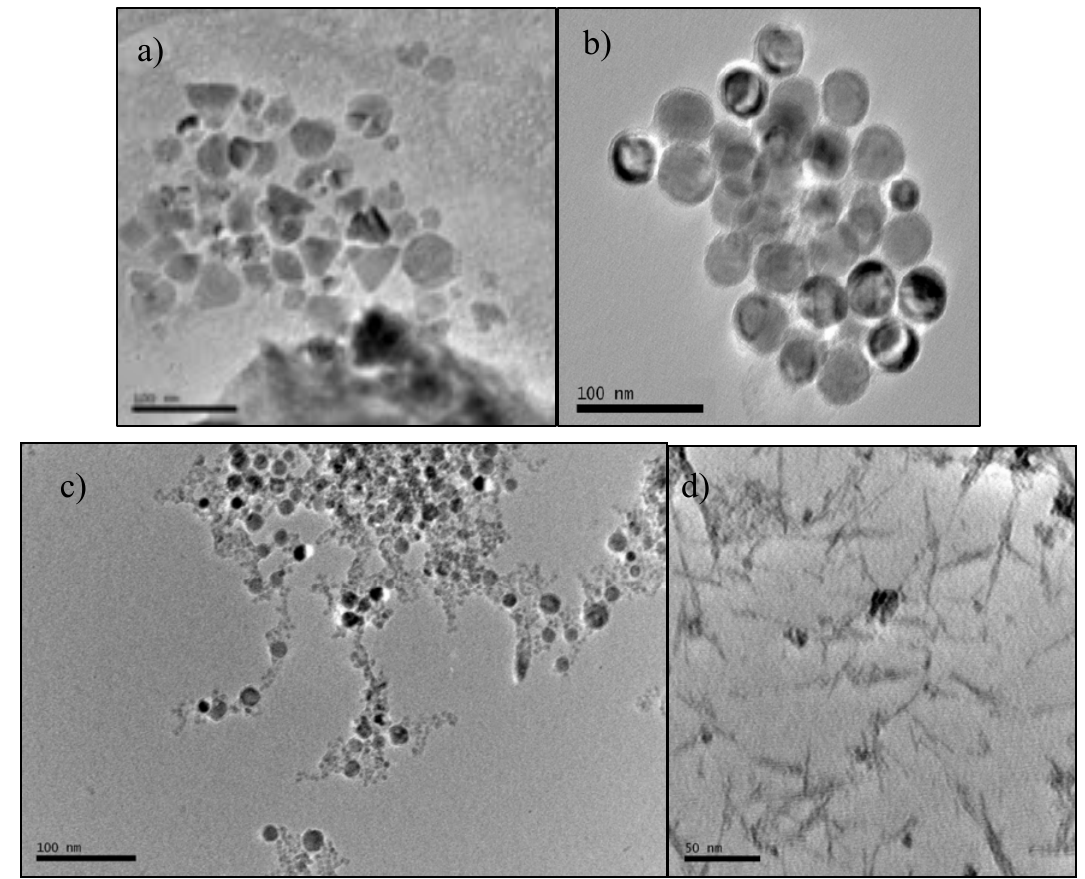
Figure 1. Transmission electron microscopy (TEM) images of Fe polyethylene glycol (PEG) capping: ( a ) polymorphous nanocrystals, scale bar 100 nm; ( b ) monodisperse spheres formed from polymorphous nanocrystals, scale bar 100